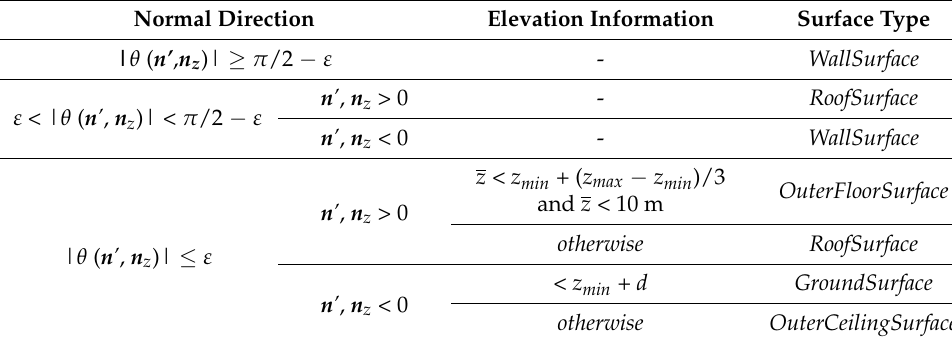
Table 4. Knowledge-based rules for determination of building surface type.